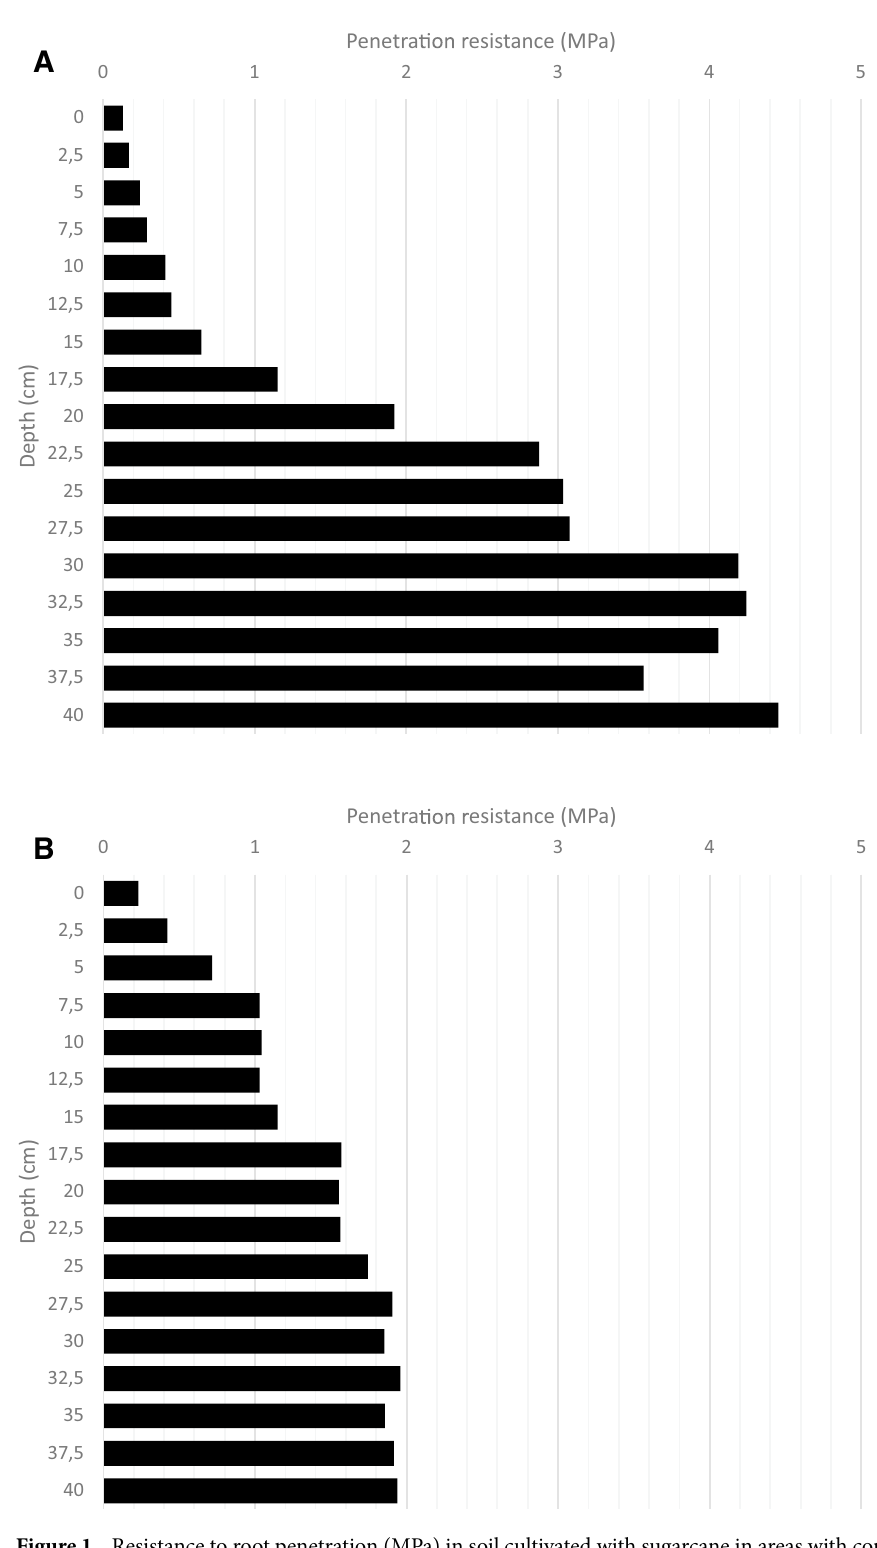
Figure 1. Resistance to root penetration (MPa) in soil cultivated with sugarcane in areas with compaction less than 4 MPa ( A ) and in areas with compaction greater than 4 MPa ( B